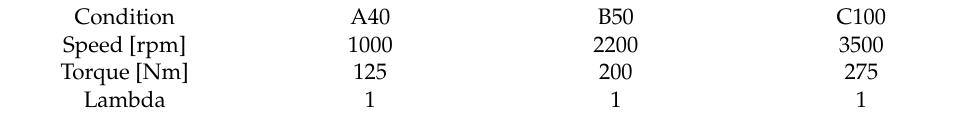
Table 3. Details of the simulated operating conditions of the light-duty natural gas engine.